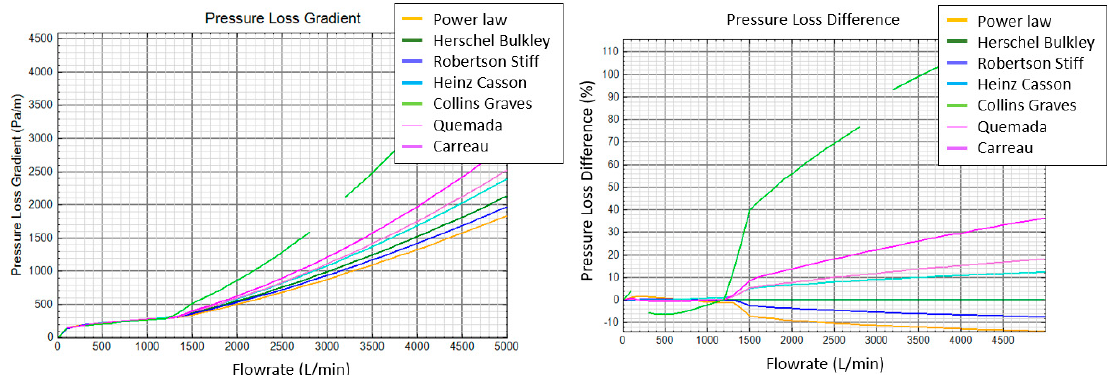
Figure 6. The estimated pressure gradients, when circulating a KCl/polymer, 1500 kg/m 3 at 80 °C, differ substantially depending on the chosen rheological behavior, especially in turbulent flow regime.